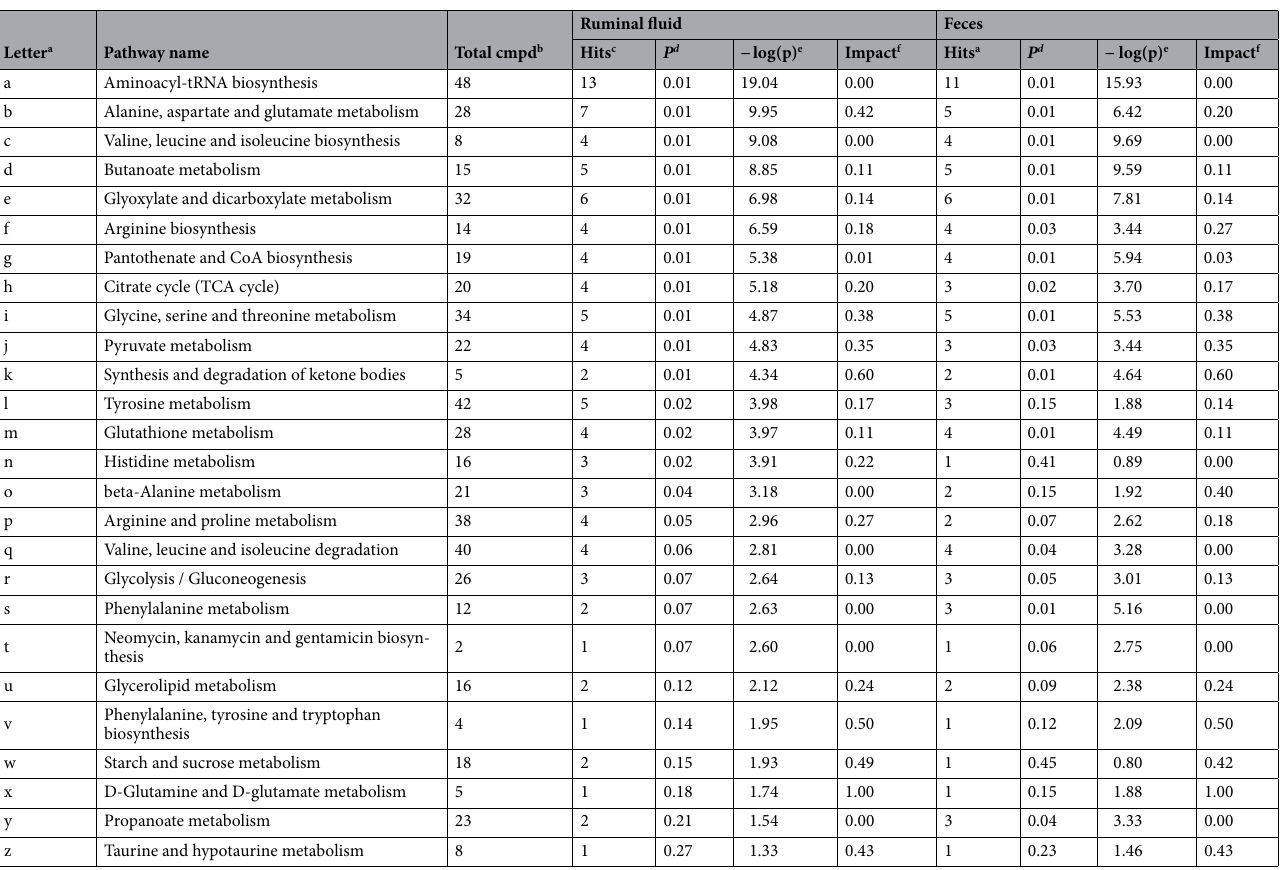
Table 2. Results from ruminal fluid and feces pathway analysis of Nellore steers. a Letter corresponds to the information shown in Fig. 3. b Total cmpd corresponds to total number of compounds in the pathway. c Hits correspond to the actually matched number from the user uploaded data. d P correspond to the original P-value calculated from the enrichment analysis. e − log(p) correspond to the P-value logarithm. f Impact correspond to the pathway impact value calculated from pathway topology